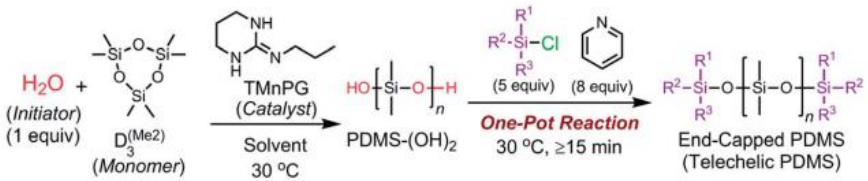
Figure 7. ROP of D 3 initiated from I 3 with U(4CF 3